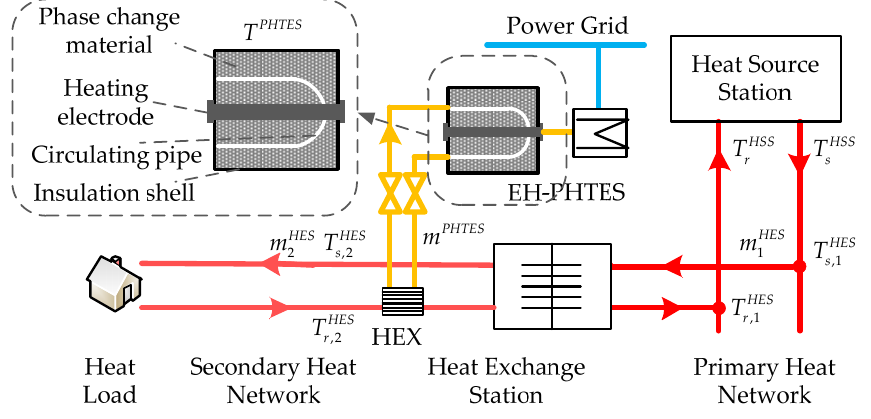
Figure 2. Internal structure and the device connections of EH-PHTES.